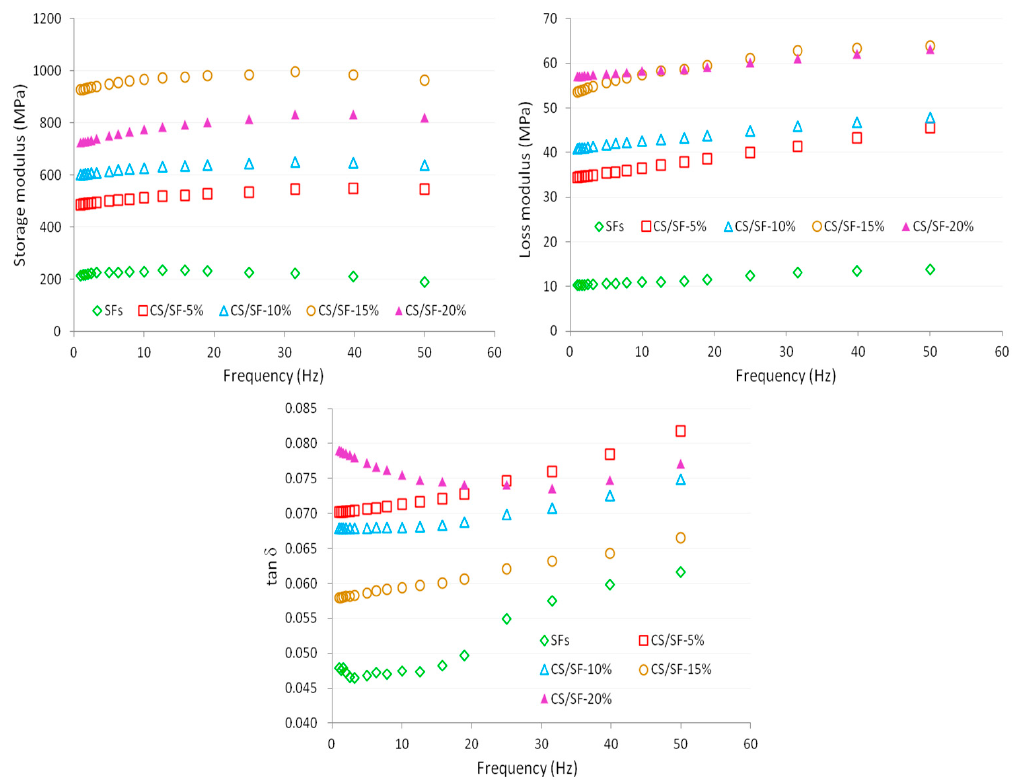
Figure 3. Storage modulus, loss modulus, and tan δ versus frequency curves of the CS/SFs with different addition amounts.